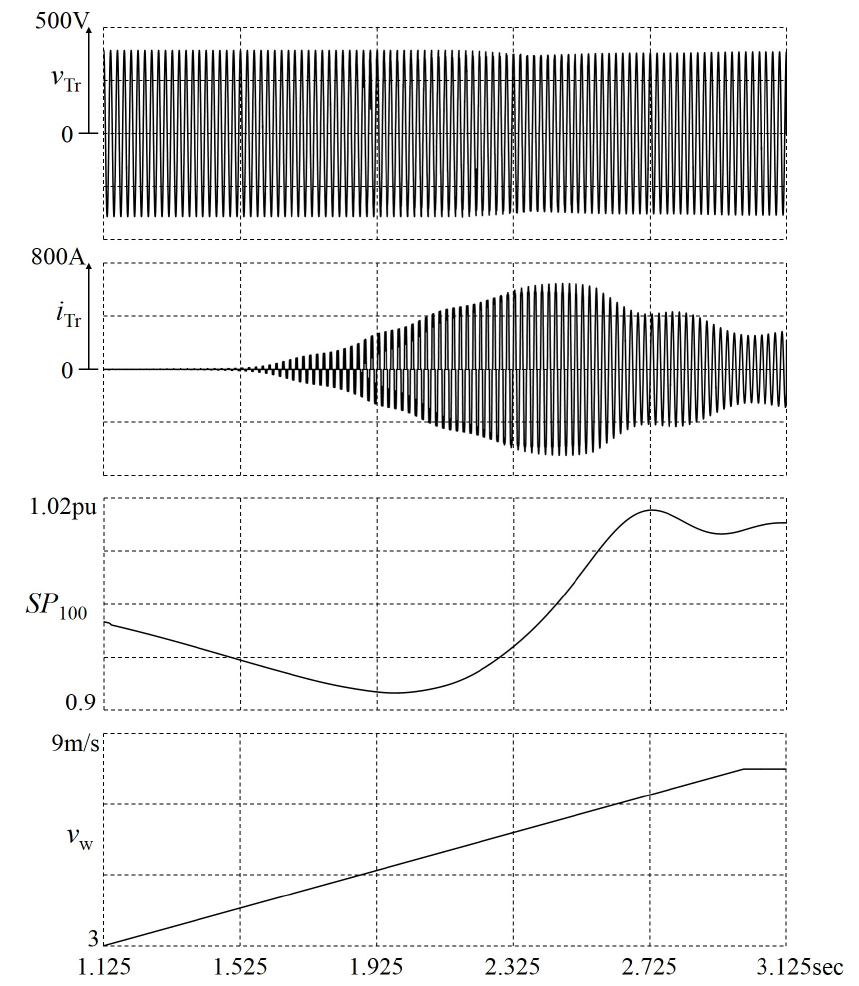
Figure 7. Simulated waveforms with a soft-starter for the 100-kW SCIM.